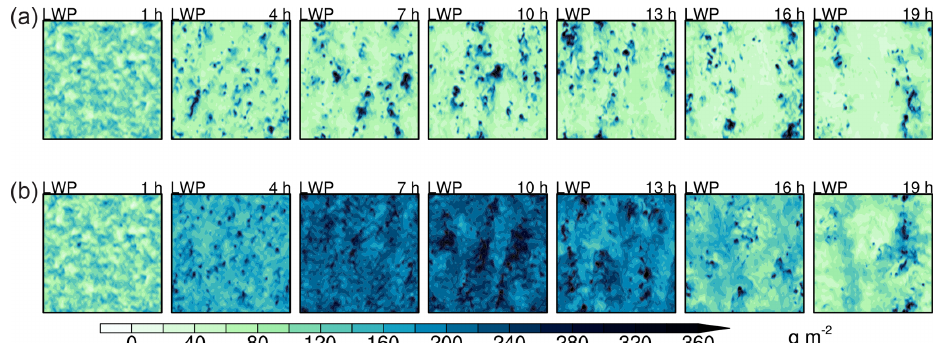
Figure 8. LWP for (a) ocean_control and the (b) open ocean 1000CCN simulation.